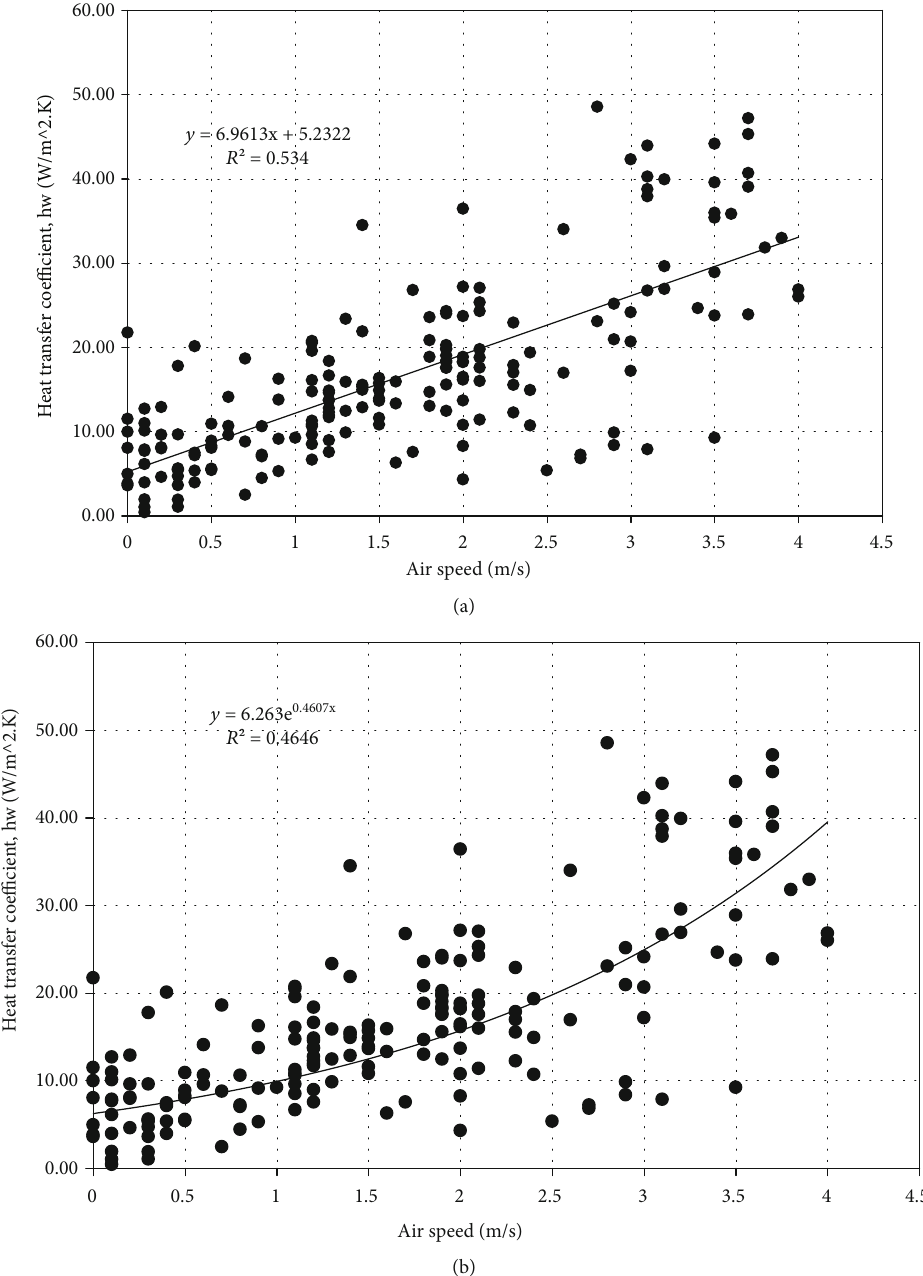
Figure 4: Regression plots: (a) linear regression of heat transfer coe ffi cient values for various air speeds and (b) exponential regression of heat transfer coe ffi cient values for various air speeds (source: Authors,